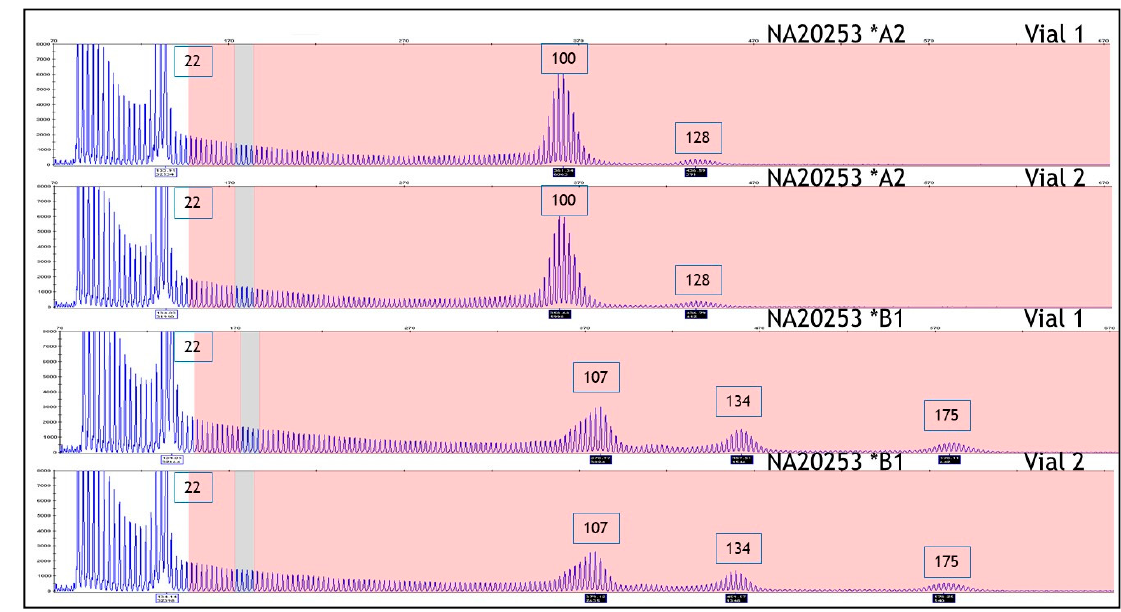
Figure 1. HTT PCR/capillary electrophoresis (CE) analysis of two lots (A2, B1) of NA20253 shows additional peaks beyond the first expanded CAG repeat peak.